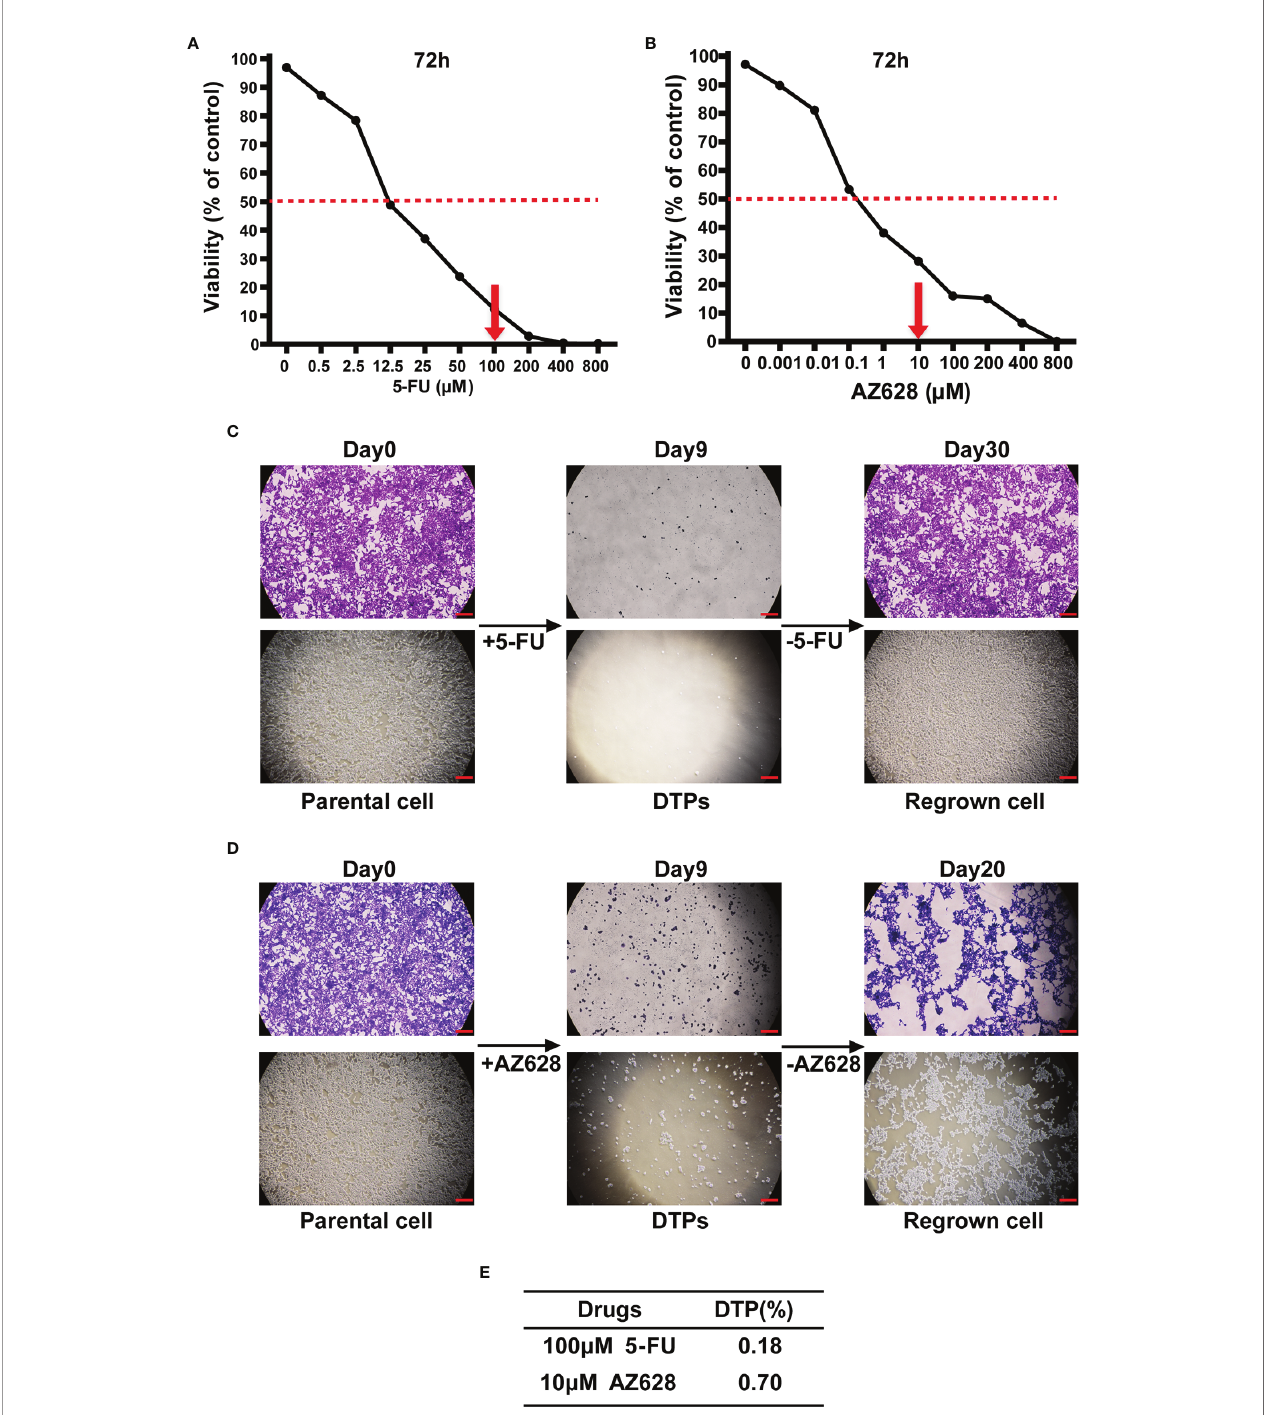
FIGURE 1 | Establishment of CRC drug-tolerant persister cell models. (A, B) Survival curves representing the viability of HCT116 cells treated with the indicated concentrations of 5- fl uorouracil (5-FU) or AZ628 for 72 hours. Each data point is expressed as the percentage of surviving cells relative to untreated controls. The dashed line corresponds to 50% cell killing. The grey arrow indicates the concentration of 5-FU (100 m M) or AZ628 (10 m M) used to generate DTP cells. (C, D) Representative pictures of crystal violet staining of HCT116 cells that were either untreated (left) or treated with 100 m M 5-FU or 10 m M AZ628 for 9 days (middle, fresh drug was added every 3 days) or removal of drugs (right). At the indicated times, representative microscope images were taken (lower panel, scale: 100 m m). (E) Following 9 days of treatment, surviving DTP cells were quanti fi ed (ratio to Day0 cell counts). Data are presented as means ± SD of three independent